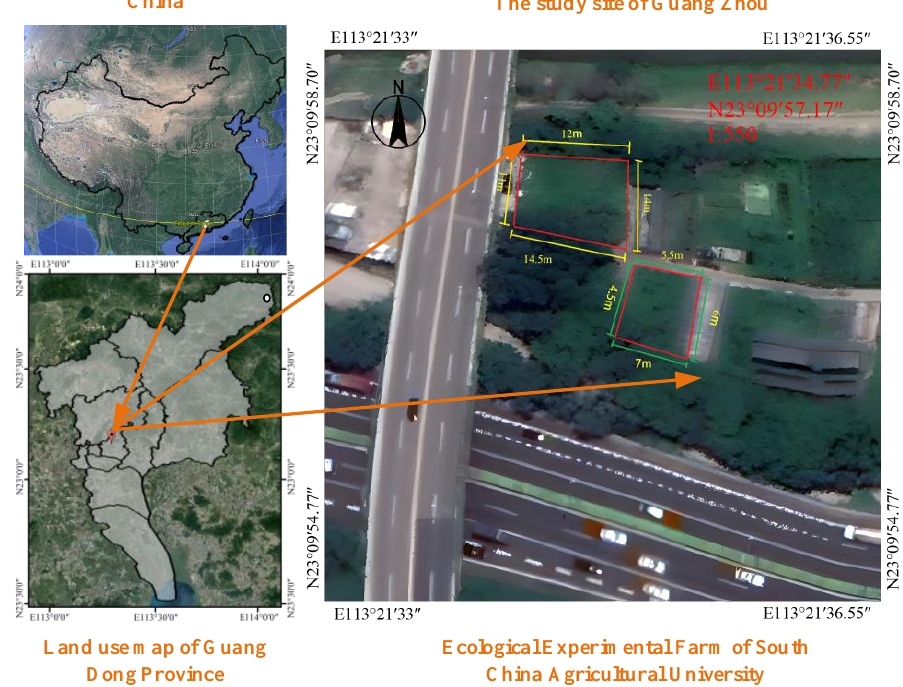
Figure 1. Location of the study sites .